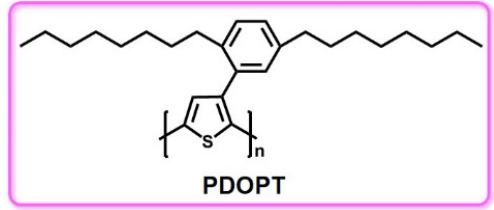
Figure 10. The chemical structure of PDOPT: poly(3-(2,5-dioctylphenyl) thiophene).